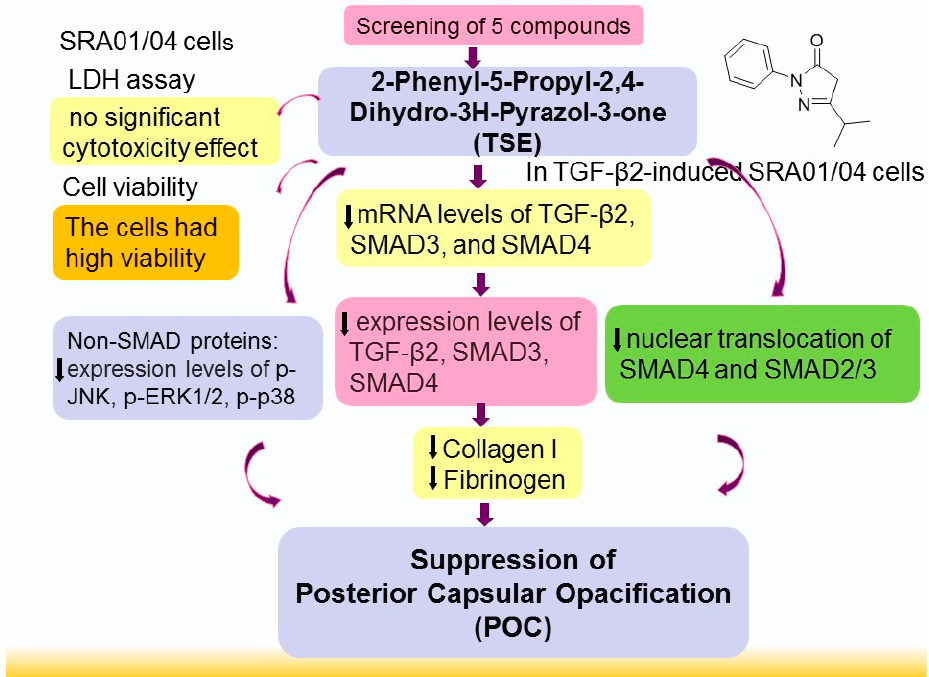
Figure 8. Graphic abstract of 2-phenyl-5-propyl-2,4-dihydro-3H-pyrazol-3-one